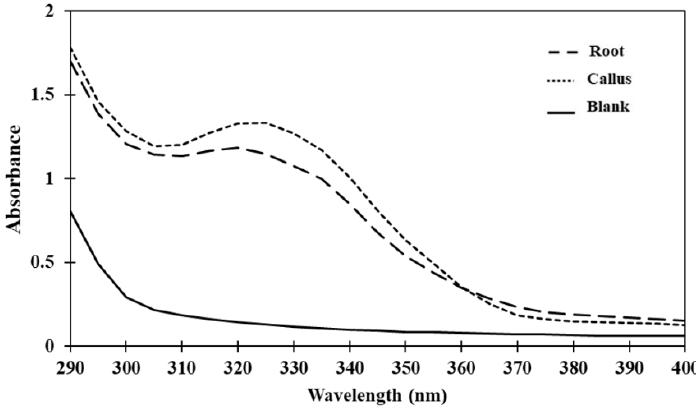
Figure 4. Ultraviolet (UV) absorption spectra of root and callus extracts.